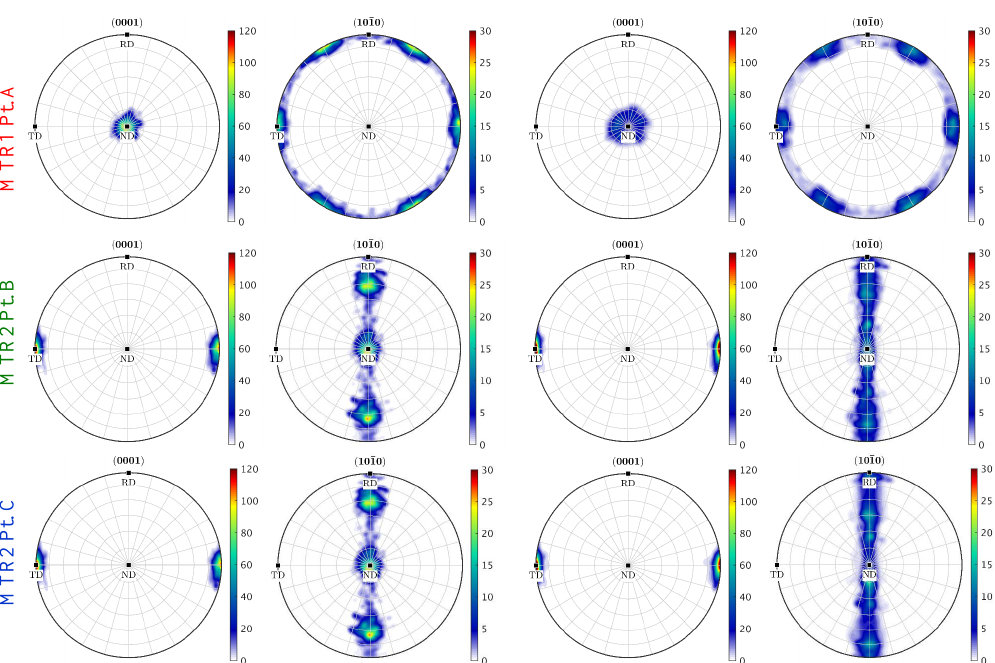
Figure 7. Microscale texture development during uniaxial ND compression simulation. Texture components soften in both MTRs, and unstable orientation is apparent in MTR2.